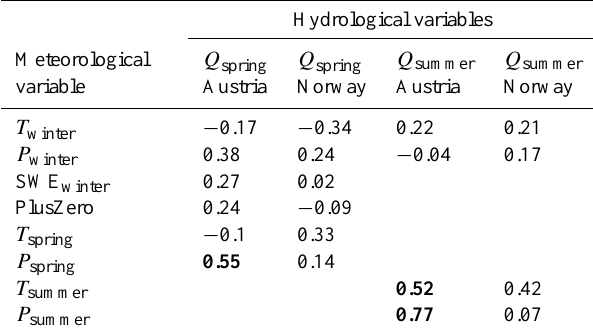
Figure A4. Glaciermelt drought events in Norwegian catchments based on simulated discharge: standardised summer discharge ( Q summer ) [–] against standardised causing factors ( T winter , P winter , T summer , P summer ) [–]. Below 1 = below average, above 1 = above average. Grey circles: all years, black circles: all drought years, coloured circles: glaciermelt drought years (size and colour of dots is dependent on standardised drought deficit [–], scale on right side of figure). NOTE: selection of (snowmelt) drought years and size and colour of dots is based on observed discharge.